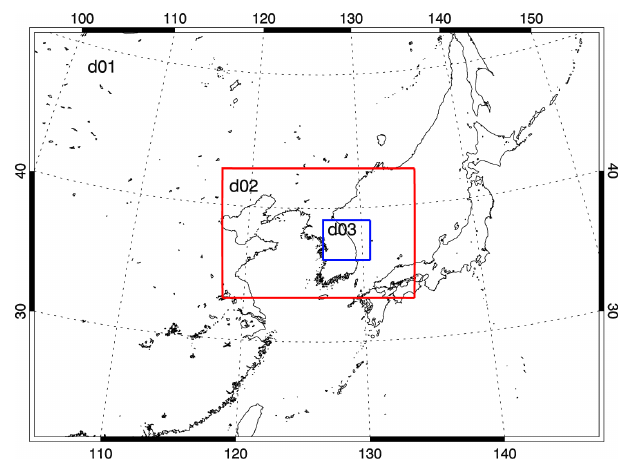
Figure 4. WRF model domain